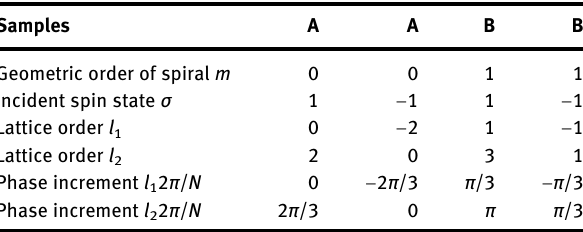
Table  : Parameters of samples A and B, denoting a metasurface with m =  and m =  ,